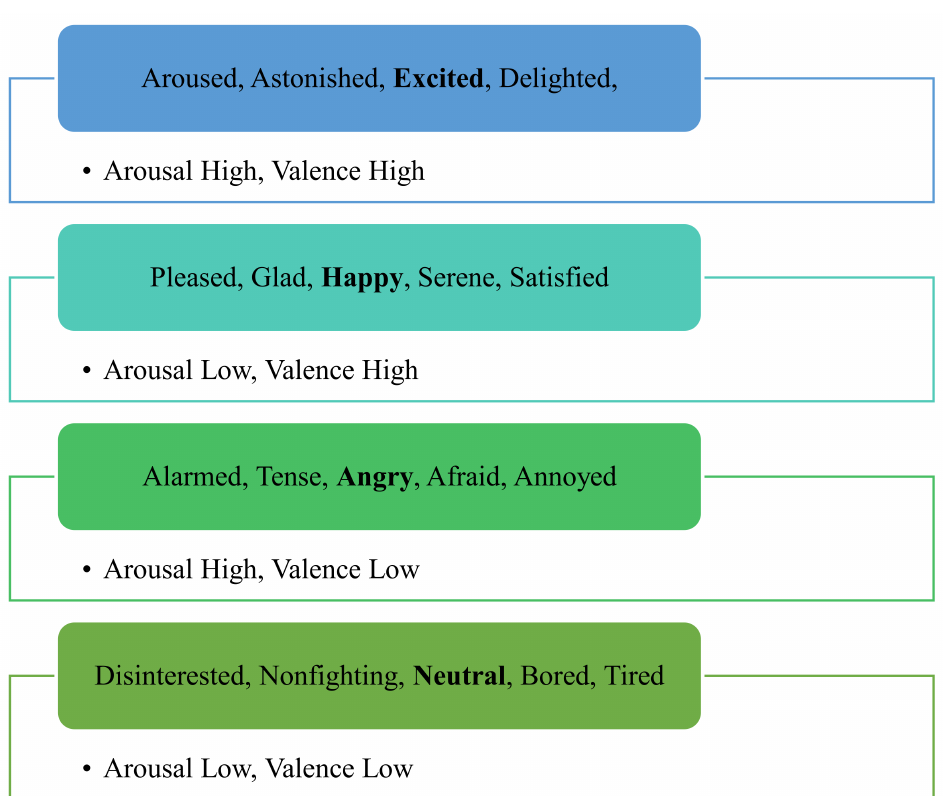
Figure 1. Circumplex model presenting arousal and valence in different emotional states adapted from